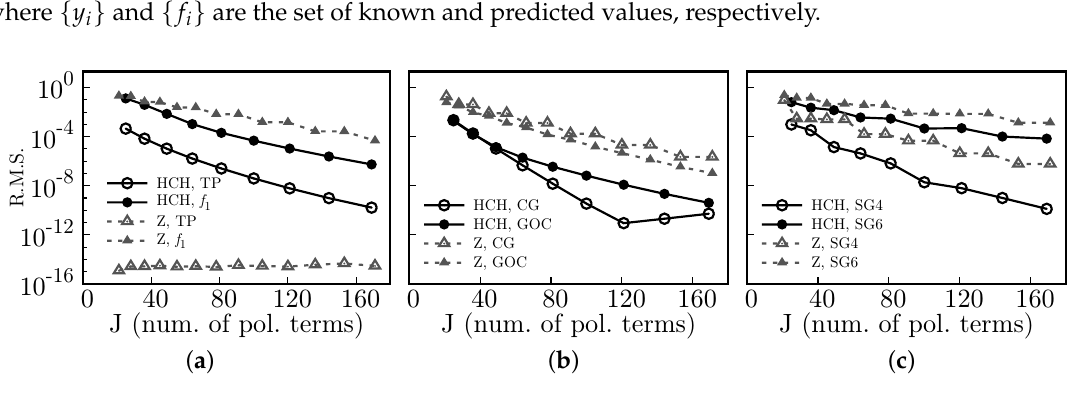
Figure 7. Compared Root Mean Square (R.M.S.) vs. J (number of polynomial terms) between Half Circular Harmonics (HCH) and the Zernike (Z) polynomials, for the test functions ( a ) Tilted Plane (TP), f 1 , ( b ) a centered Gaussian (GC), an off-centered Gaussian (GOC), and ( c ) super-Gaussians of order 4 (SG4) and 6 (SG6).